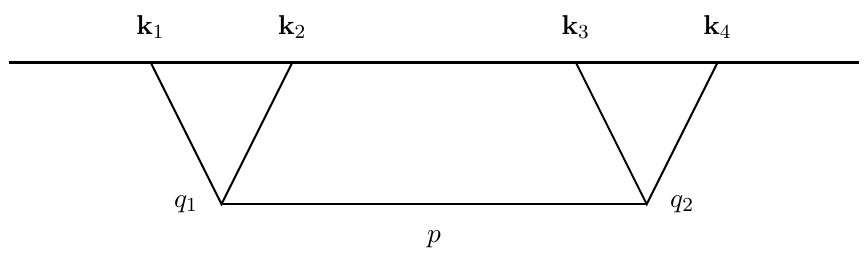
Figure 7 . The scalar quartic wavefunction ψ s